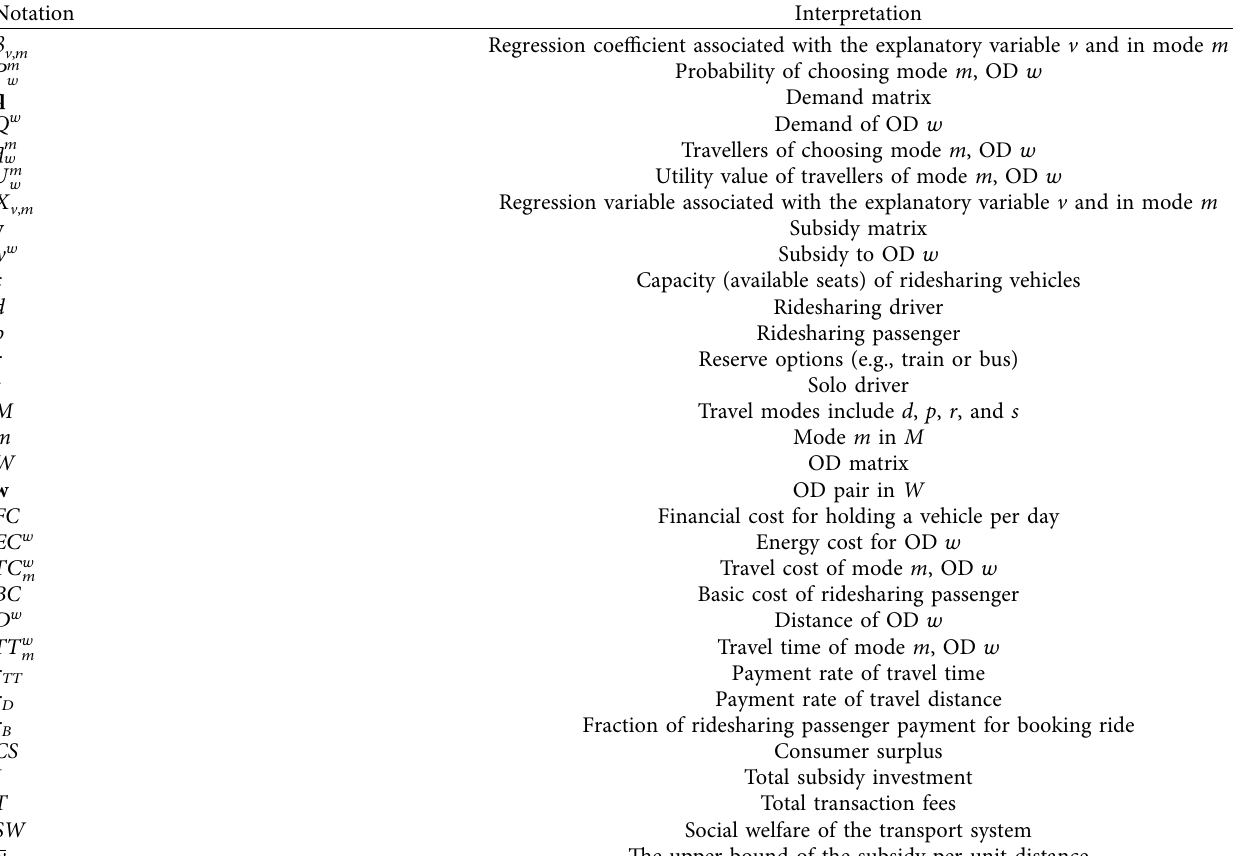
Table 2: Signs and